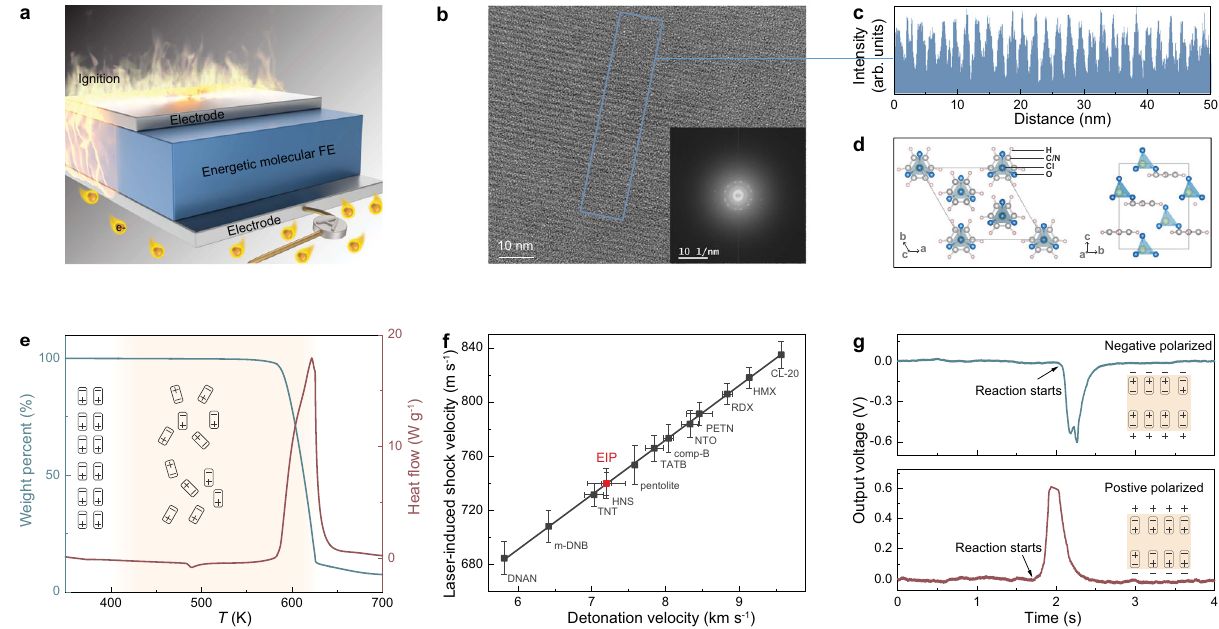
Fig. 1 Chemical driven electricity in EIP. a Schematic fi gure for electricity generation in energetic molecular ferroelectrics (FE). b HRTEM images for EIP. Inset shows the FFT pattern re fl ecting the high crystallinity of EIP. c Line pro fi le for selected area in Fig. 1b. d Crystal structure of ferroelectric EIP. e Thermogravimetric analysis and differential scanning calorimetry measurement for EIP. Supplementary Figure 5a highlights the transition at 373 K. f The laser-induced shock and detonation velocity of EIP. Error bars show standard deviations. DNAN (2,4-dinitroanisole); m -DNB ( m -dinitrobenzene); TNT (trinitrotoluene); HNS (hexanitrostilbene); TATB (triaminotrinitrobenzene); comp-B (Composition B); NTO (5-nitro-2,4-dihydro-3H-1,2,4-triazole-3-One); PETN (pentaerythritol tetranitrate); RDX (cyclotrimethylenetrinitramine); HMX (cyclotetramethylene tetranitramine); CL-20 (hexanitrohexaazaisowurtzitane). g The DC voltage generated by reaction of EIP is observed immediately after ignition in both positive and negative polarization. EIP devices are ignited thermally. The gap distance between the electrodes is 1.2mm and the cross-sectional area is 16mm 2